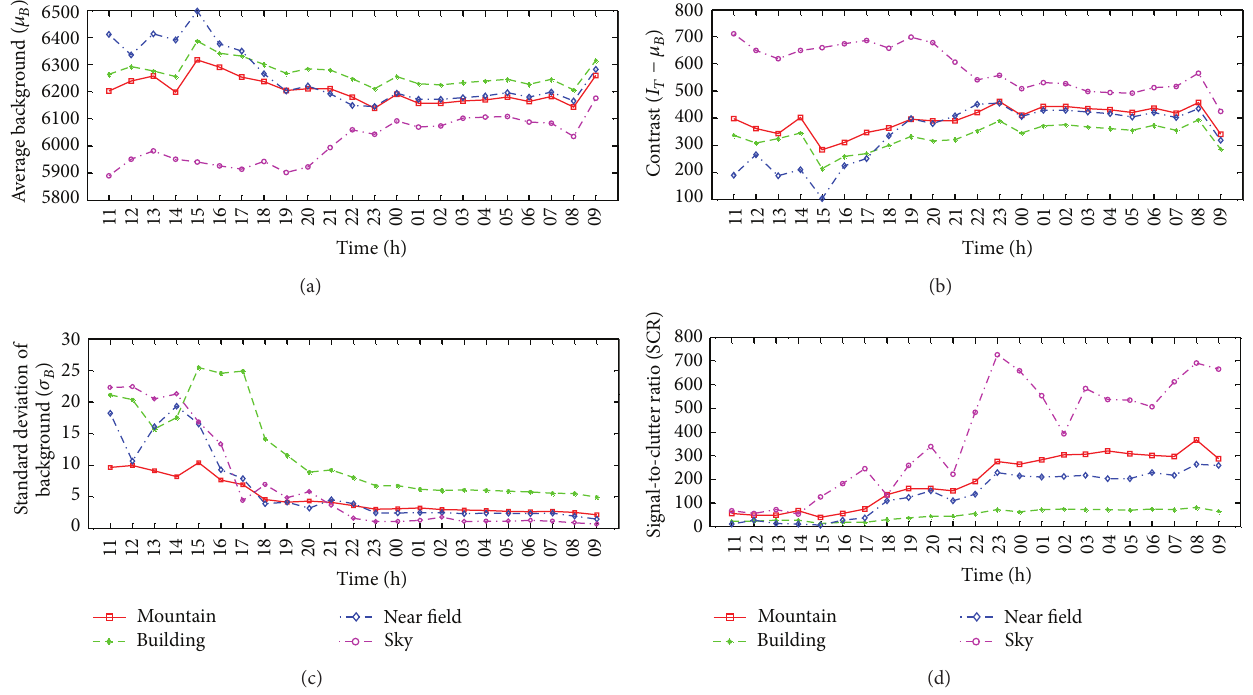
Figure 13: Variation analysis of spring according to the recording time: (a) average background versus time, (b) contrast versus time, (c) standard deviation versus time, and (d) SCR versus